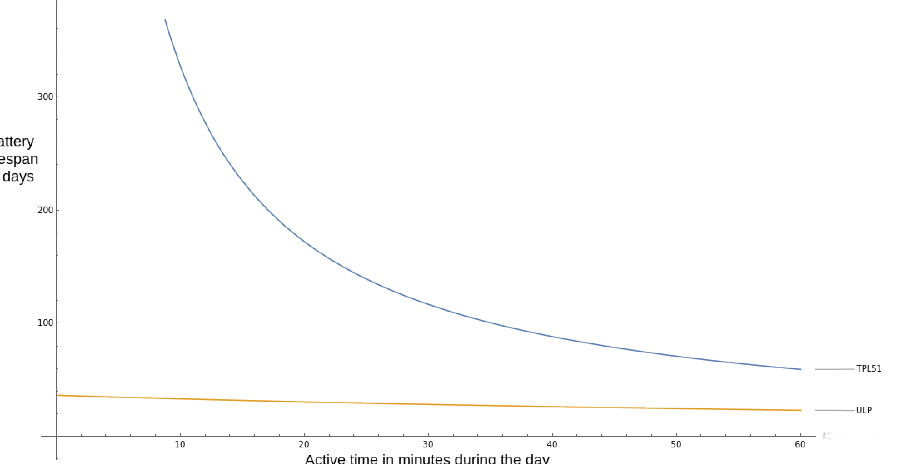
Figure 8. 2000 mAh battery lifetime when using TPL5111 and ULP in sleep mode, based on node active